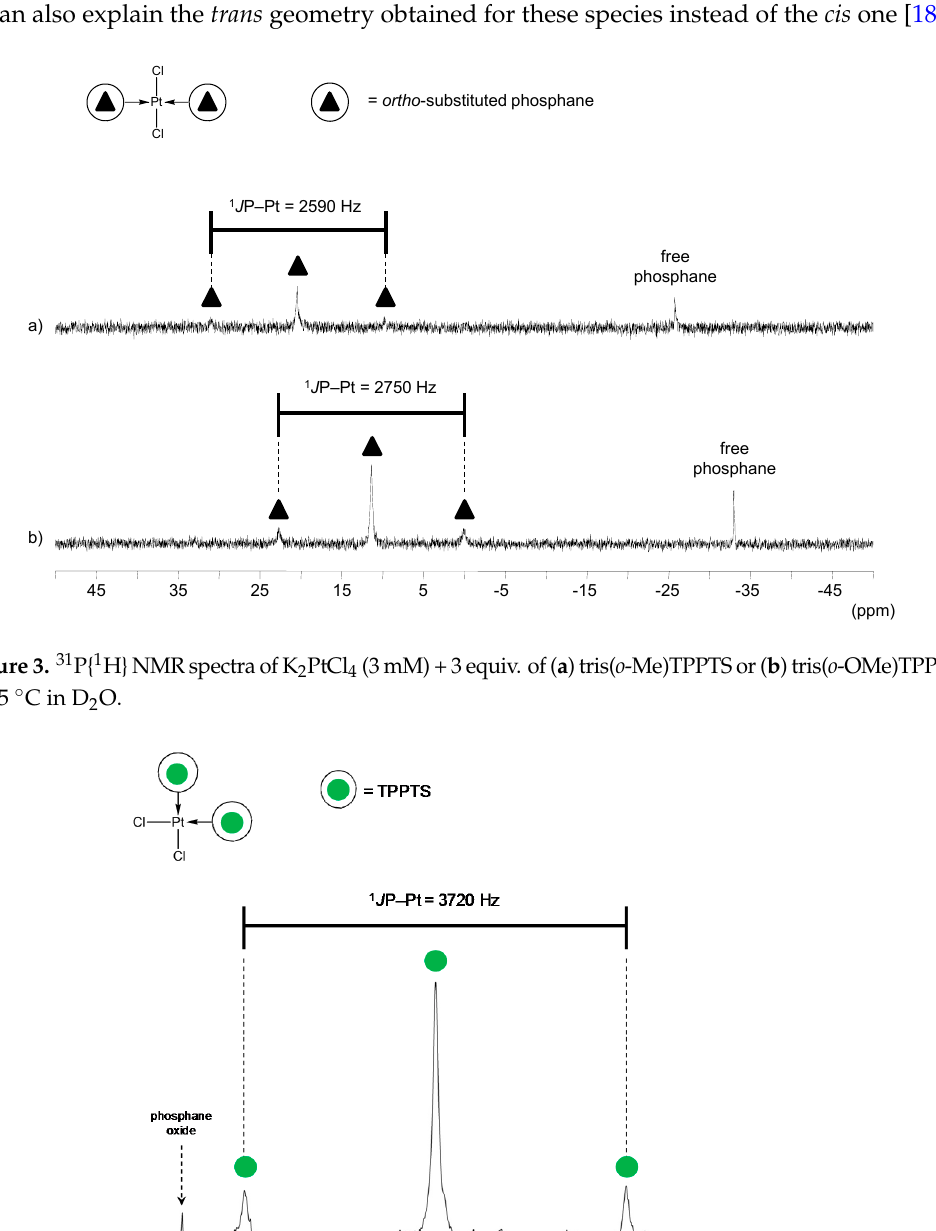
Figure 4. 31 P{ 1 H} NMR spectrum of cis -PtCl 2 (TPPTS) 2 , [Pt] = 10 mM, 25 °C in D 2 O.